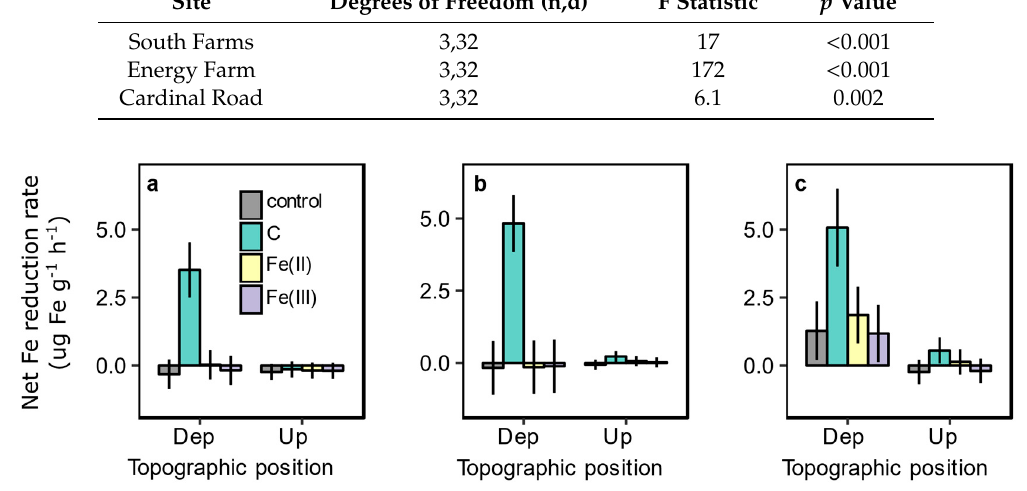
Figure 7. Net Fe reduction rates in depressional and upslope areas at the South Farms ( a ), the Energy Farm ( b ), and Cardinal Road ( c ) during the late season experiment (mean ± SE, n = 5). Colors represent different treatments.